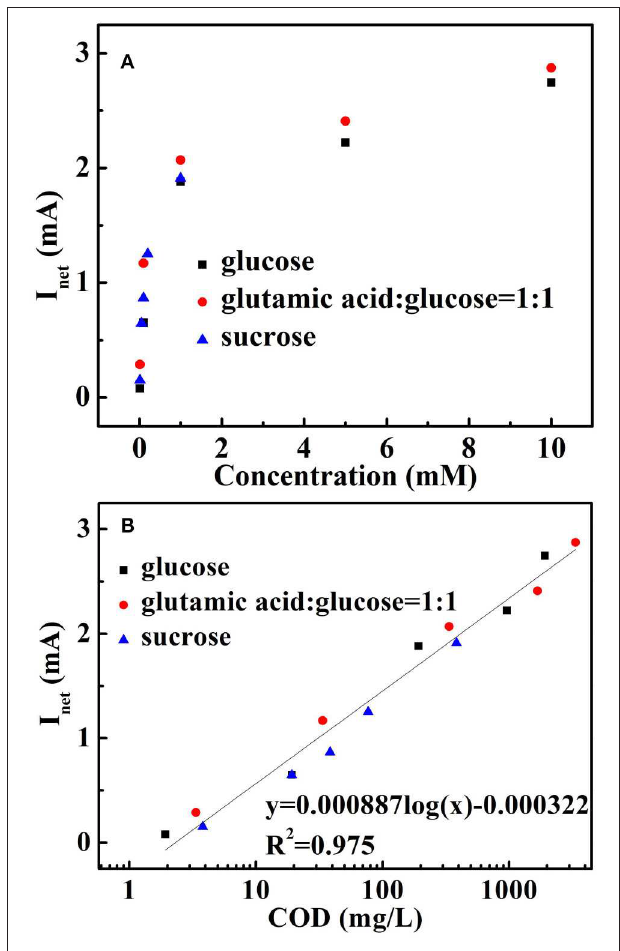
FIGURE 8 | Verification of analysis principle: (A) the correlation of I net and molar concentrations of selected organic compounds; (B) the relationship between I net and the theoretical COD values of the selected organic